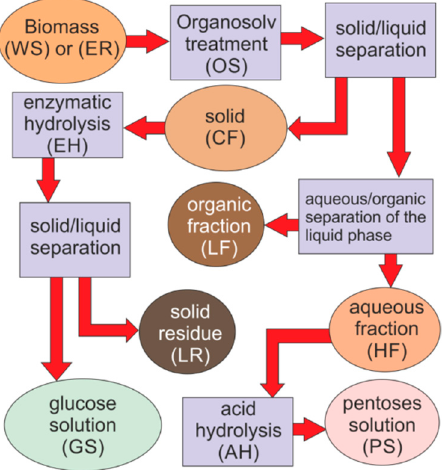
Figure 3. Process scheme of biomass pretreatment, fractionation and hydrolysis.